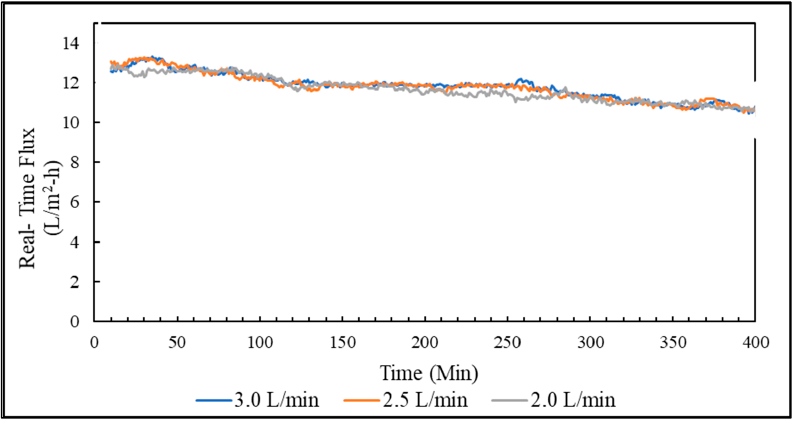
Figure 6. Flow rate comparison of FO system shown as moving average 10 data points.